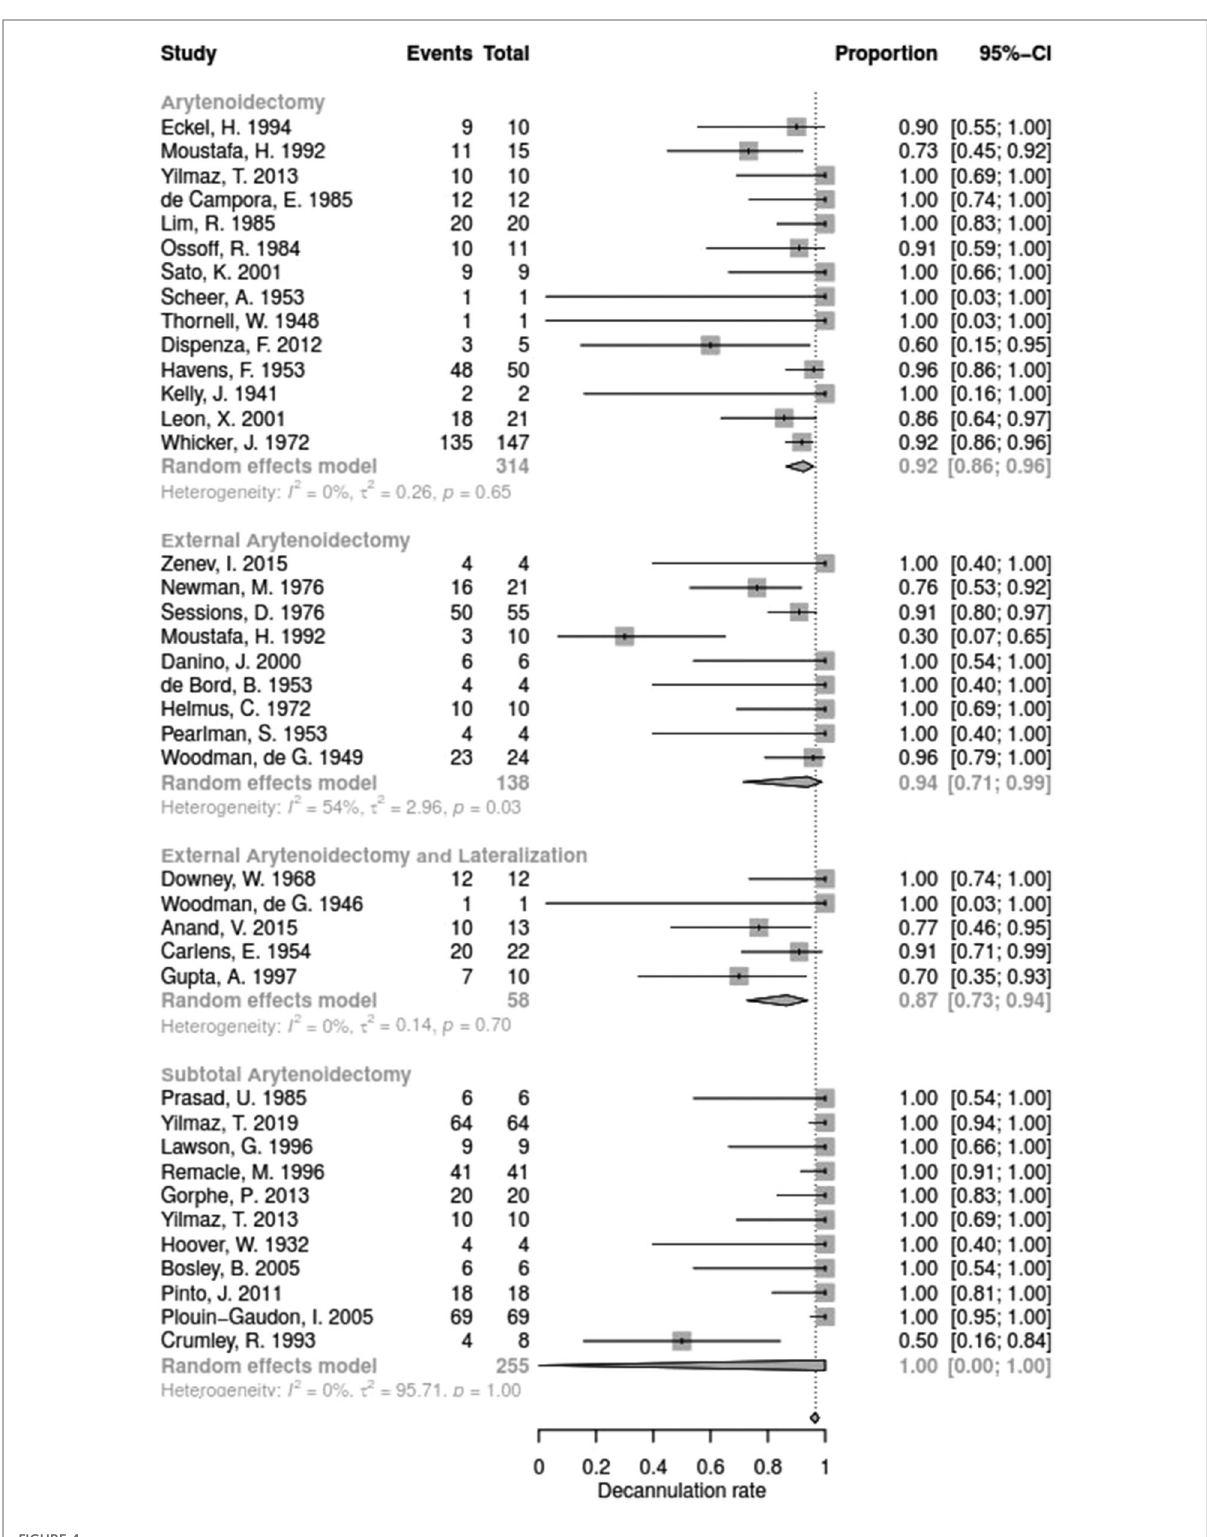
FIGURE 4 Forest plot of decannulation rates in studies on